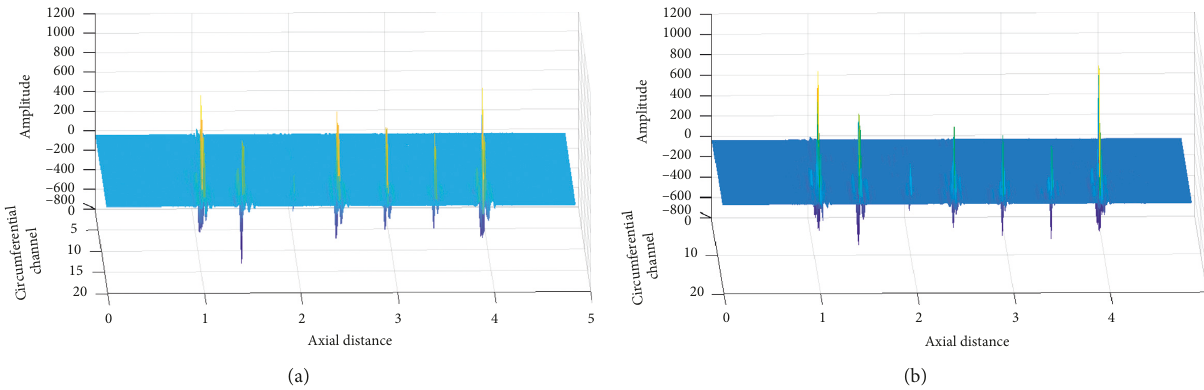
Figure 9: The original denoising wire rope MFL image. (a) The first board. (b) The second